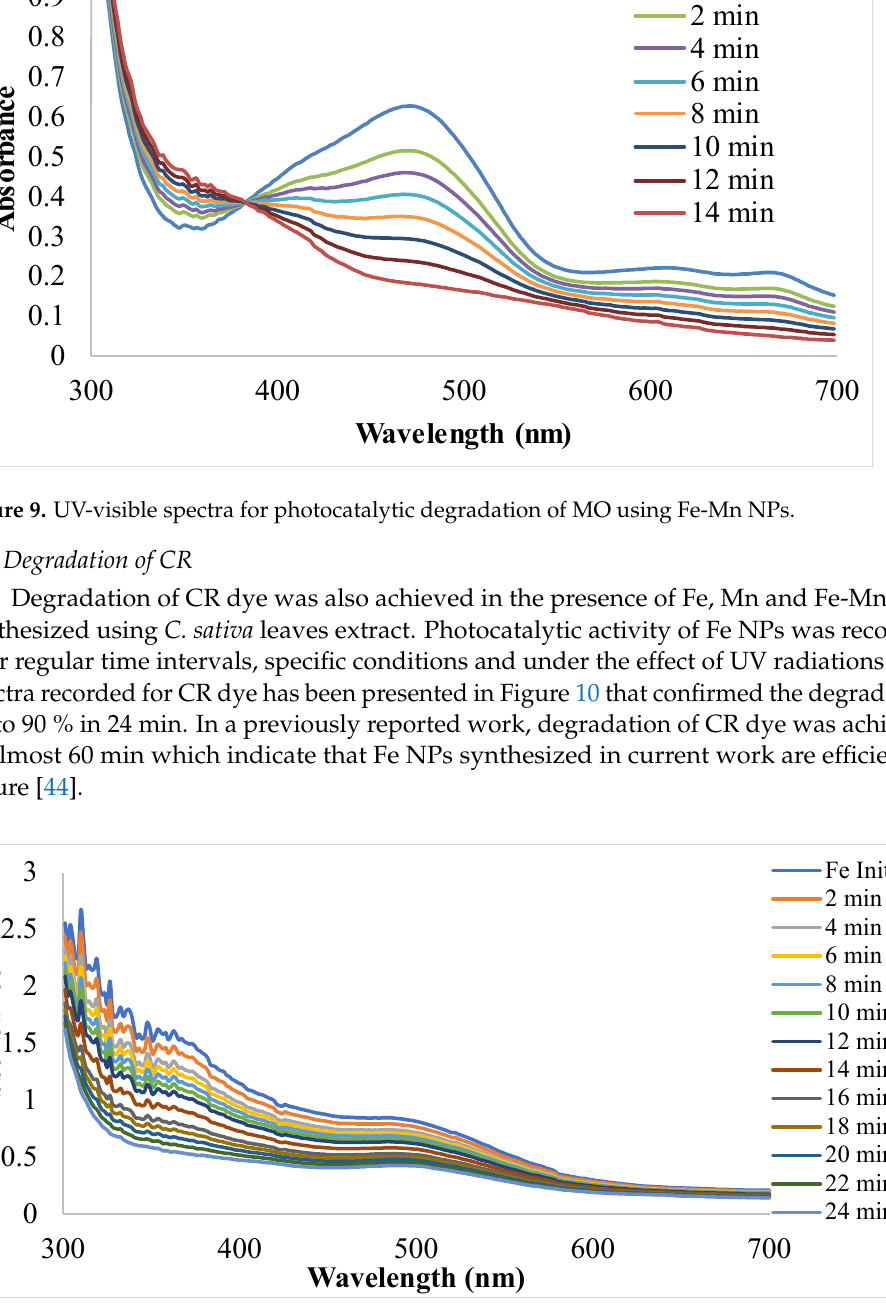
Figure 10. UV-visible spectra for photocatalytic degradation of CR using Fe NPs.